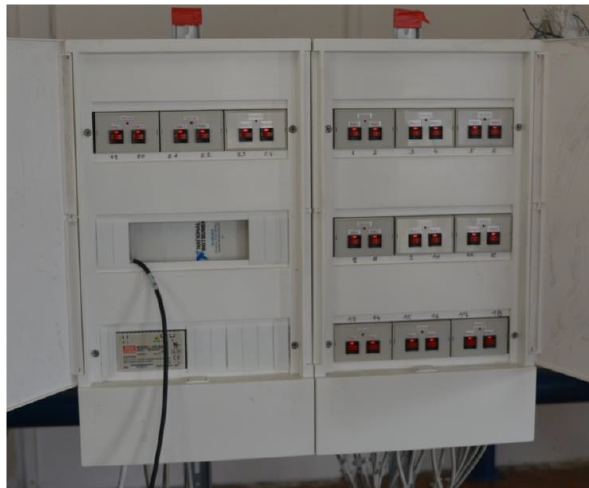
Figure 6: Set of A/D converters